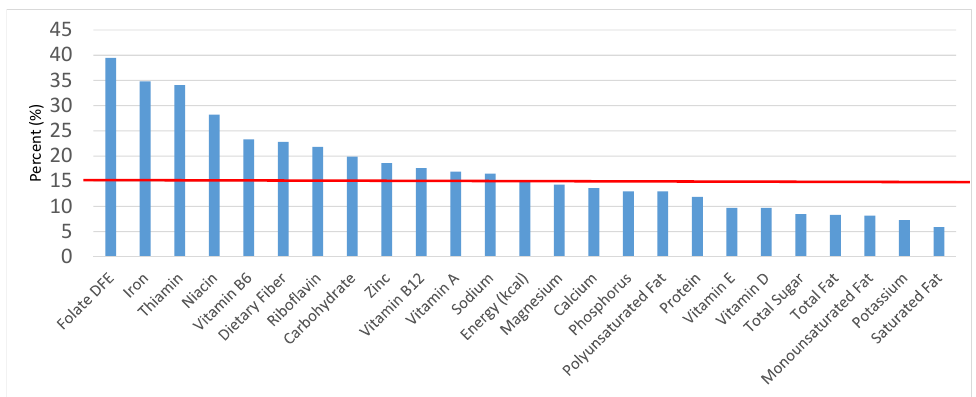
Figure 4. Grain foods sources of energy and nutrients for children and adolescents 9–13 years old ( N = 1730, daily intake data): DFE = Dietary Folate Equivalents; solid red line represents percentage of energy (kcal) provided in the diet relative to nutrients—nutrients above the red line show the grain food’s contribution to nutrient density.